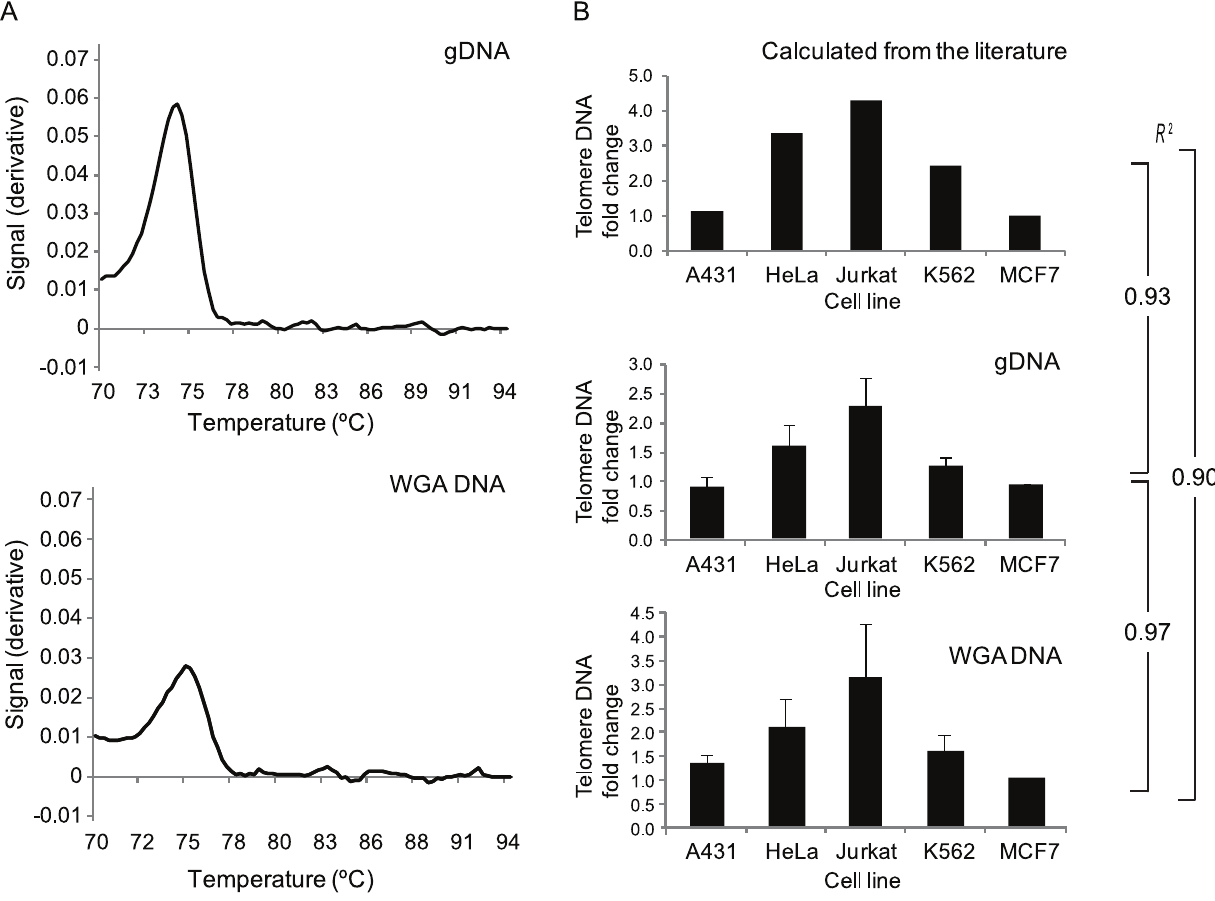
Figure 1. Valdiation of a novel assay for telomere DNA relative quantitation from limited amounts of starting material. (A) The telomere DNA assay amplification product produced a single peak upon dissociation curve analysis demonstrating specificity on purified genomic (g) DNA from a large quantity of cells, and from whole genome amplified (WGA) DNA from picogram quantities of purified gDNA. (B) Quantities of telomere DNA in various cancer cell lines relative to MCF-7 cells either reported in the literature or determined with the assay developed in this study. In each case, the Pearson correlation coefficient (R 2 ) of the relative quantitation profiles are shown and illustrate the maintenance of relative abundance after characterization of picogram quantities of starting material.